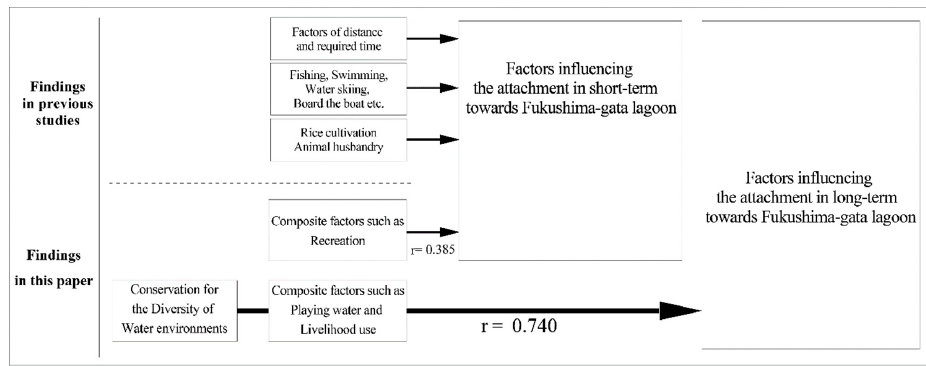
Figure 13. Factors affecting the formation of attachment.